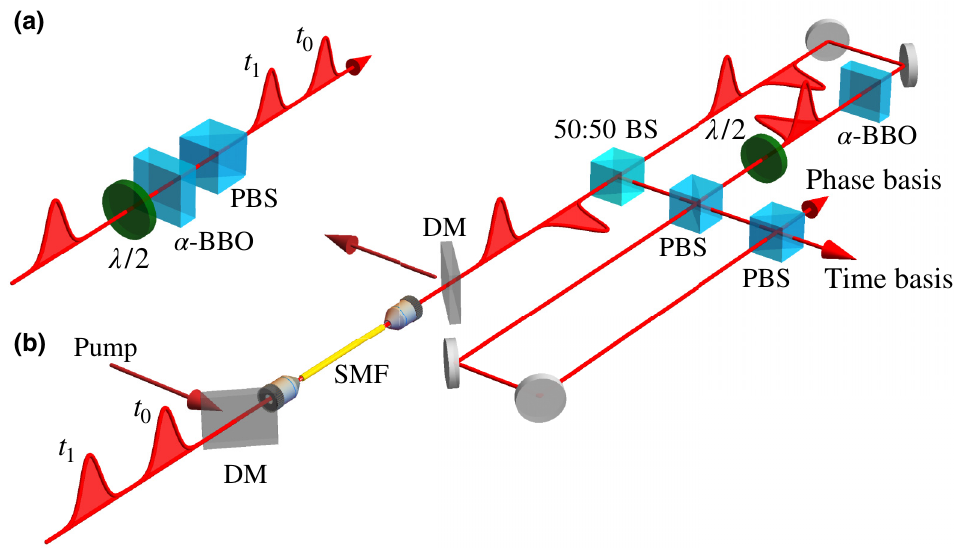
FIG. 2. The experimental setup. A simplified experimental setup showing the state preparation and the state detection of ultrafast time-bin qubit states in a BB84 protocol experiment. (a) In the state-preparation stage, an ultrashort pulse is sent to a 10-mm-long α - BBO birefringent crystal, splitting the input pulse into two output pulses with orthogonal polarization separated by 4.5 ps. A polarizing beam splitter (PBS) is then used to erase the polarization information associated with each time bin, resulting in a uniformly polarized time-bin state. The weight and relative phase of the time-bin state can be determined by a half-wave plate ( λ/ 2), placed before the α BBO. (b) In the detection stage, the signal pulse is combined with a strong pump pulse at a dichroic mirror (DM) and then coupled to a single-mode fiber where the pump pulse switches the early time bin. The pump pulse is then filtered out using a DM and further spectral filters not shown in the figure. A 50:50 beam splitter (BS) is used to randomly switch the measurement setting from the time basis (the reflected output) to the phase basis (the transmitted output). In the time basis, a delayed interferometer is designed with a path difference of 88 cm such that the time-bin state can be detected by measuring the time of arrival of the pulse with standard single-photon detectors. In the phase basis, a second 10-mm α -BBO crystal is used to recombine the pulses and convert the relative phase information to polarization. The same delayed interferometer can be used in parallel where the phase state is determined from the time of arrival of detected